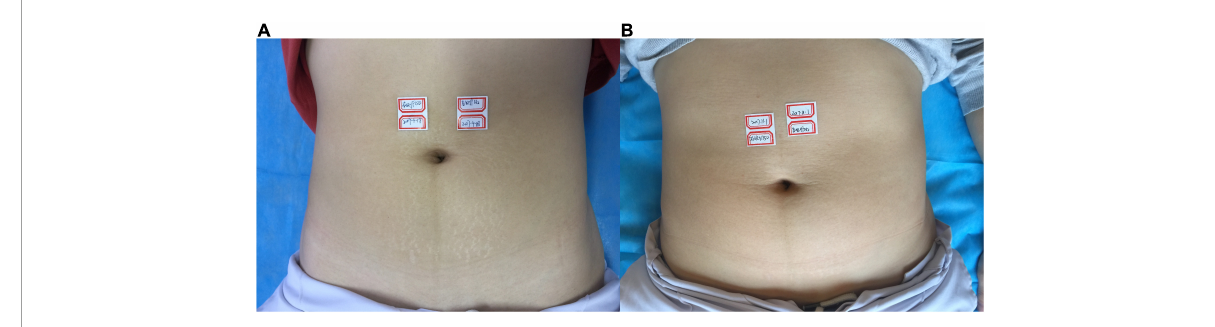
FIGURE5 (A) Before treatment; (B) 3 months after the final treatment, the left clinical efficacy score was 4; the right side was 4.